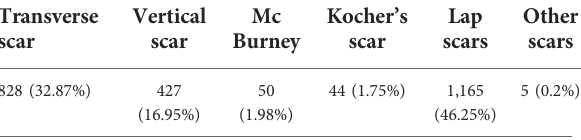
TABLE 4 Distribution of patients according to the type of scar of previous surgery.